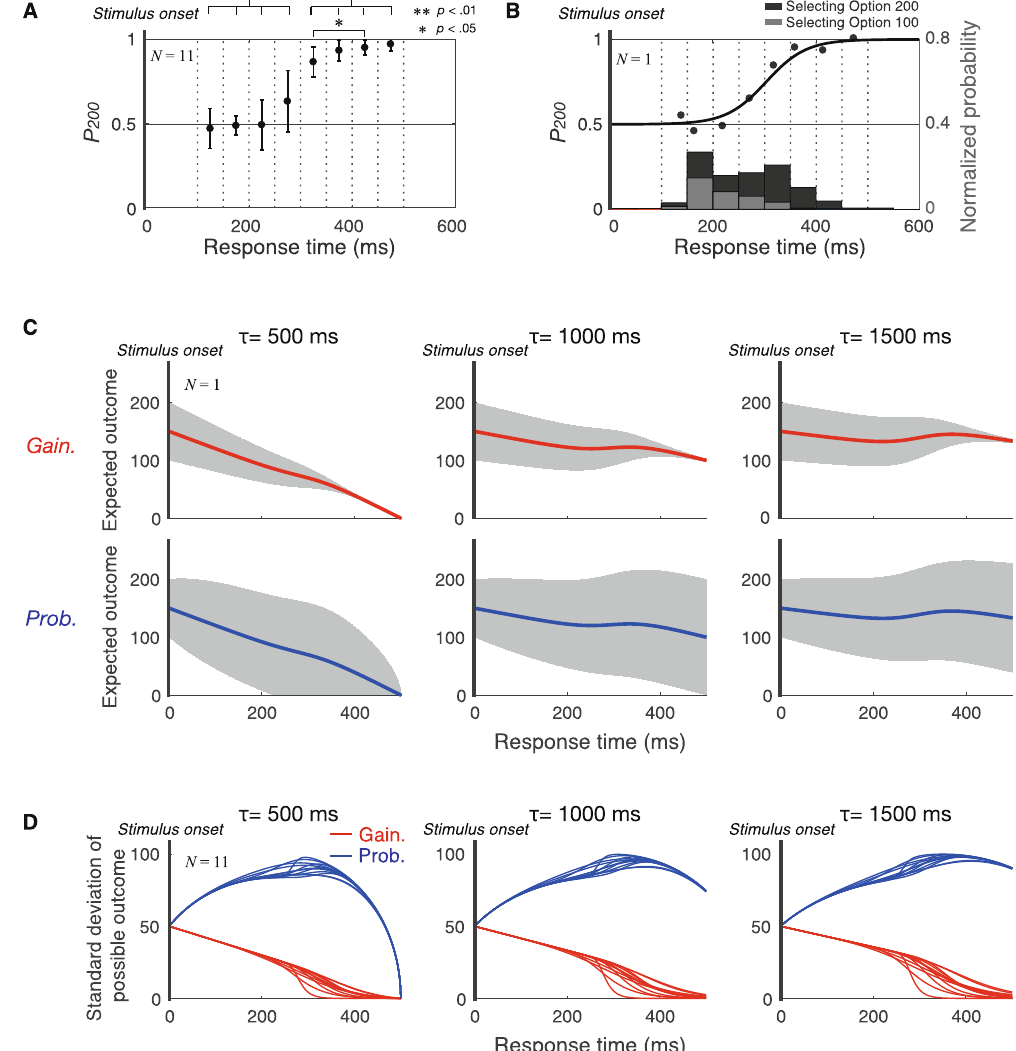
Figure 2. Three steps to estimate time changes in variance of possible outcomes. ( A ) Relationship between response time and probability of selecting Option 200. The black circles indicate the mean of the probability of each participant selecting Option 200 ( P 200 ) and the black bars indicate between-participant SD of P 200 . The asterisks above a line indicates that the difference between P 200 for the corresponding response times was significant (paired t -test with Bonferroni correction). These results indicated that the speed-accuracy tradeoff was confirmed for this task. ( B ) Histogram of response times for selecting Option 100 (gray) and Option 200 (black). The probability of selecting Option 200 ( P 200 ) is plotted as a function of the response time binned in eight equal intervals (50 ms) from 100 to 500 ms. The response time include both the gain-decrease and probability-decrease condition. The black curve shows the model fit using modified logistic regression and indicates the relationship between the response time and P 200 (i.e., participant’s own speed-accuracy tradeoff). The histogram shows the distribution of the response time across equal intervals (50 ms). The figures obtained from each participant are shown in Supplementary Fig. 1. ( C ) Time changes in the expected outcomes in the gain-decrease (red) and probability-decrease (blue) conditions. The shaded gray area indicates the variance of possible outcomes. These were based on data from an individual participant. The expected outcomes ( EO ) depending on time were estimated using participants’ speed-accuracy tradeoff ( A ). Since the expected gain of each option at each time point was equivalent between both conditions, the expected outcome depending on time was the same between conditions. ( D ) Time changes in variance of possible outcomes. The blue and red lines show the time changes in variance (risk) of possible outcomes for each participant in gain-decrease and probability-decrease conditions, respectively. In the gain-decrease condition, when participants selected Option 200, variance became small. In the probability-decrease condition, variance became large when participants selected Option 200, since the probability of obtaining no reward or obtaining 200 points simultaneously